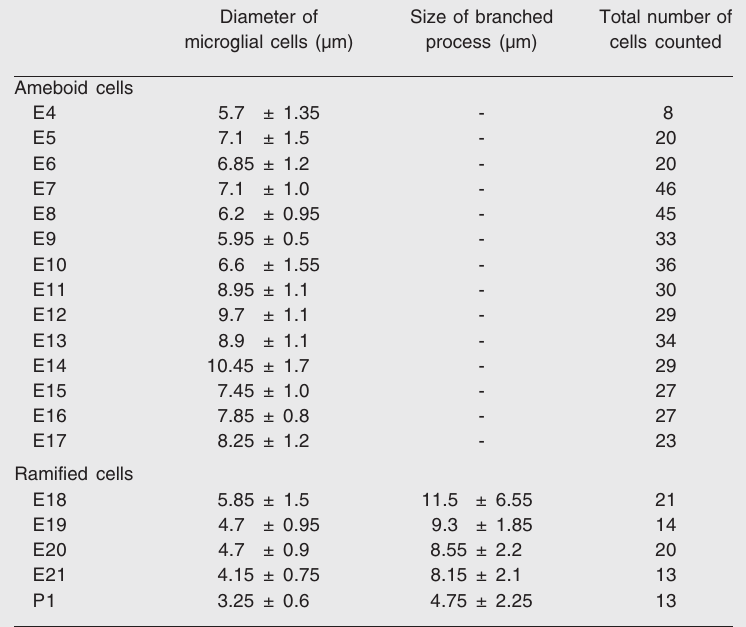
Data are reported as means ±